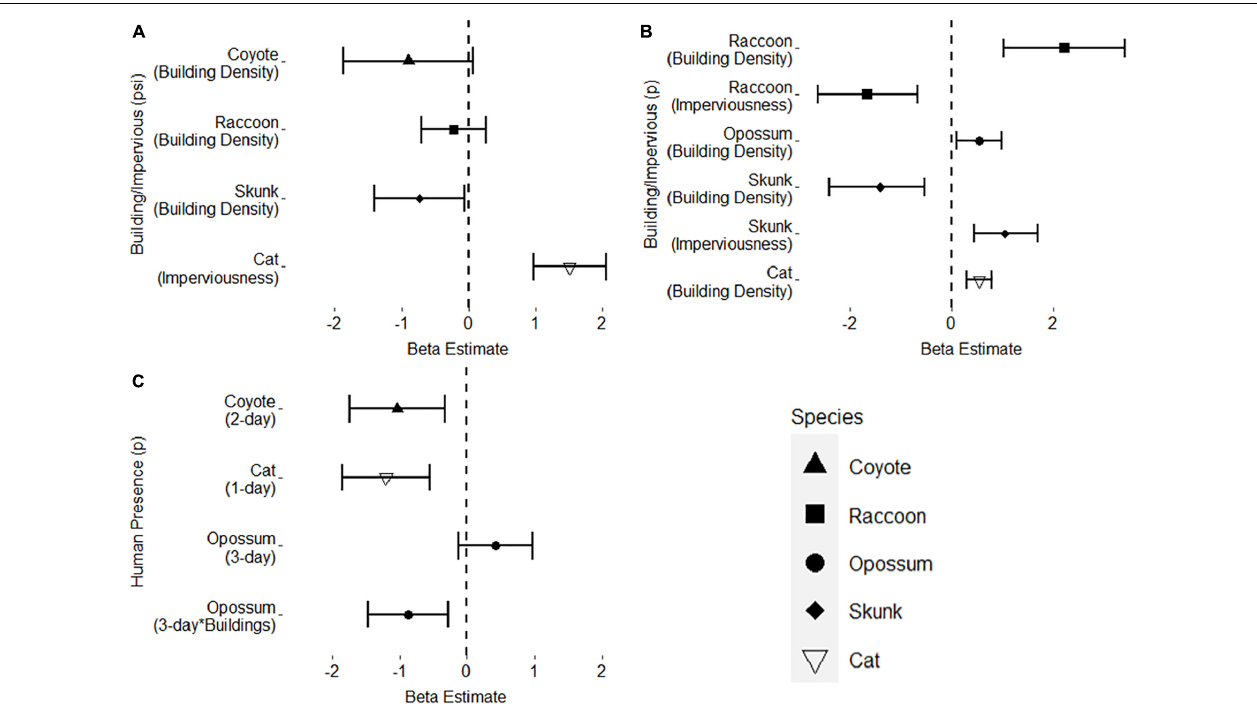
FIGURE 2 | Beta estimates and 95% confidence intervals for top single-species mesopredator occupancy models. Beta estimates that cross the dashed line at 0 are not considered significant. (A) Top urbanization covariates, building density and imperviousness, for mesopredator occupancy. (B) Top urbanization covariates, building density and imperviousness, for mesopredator detection. (C) Top human presence covariates for mesopredator detection as well as an interaction term for human presence across building density for opossum